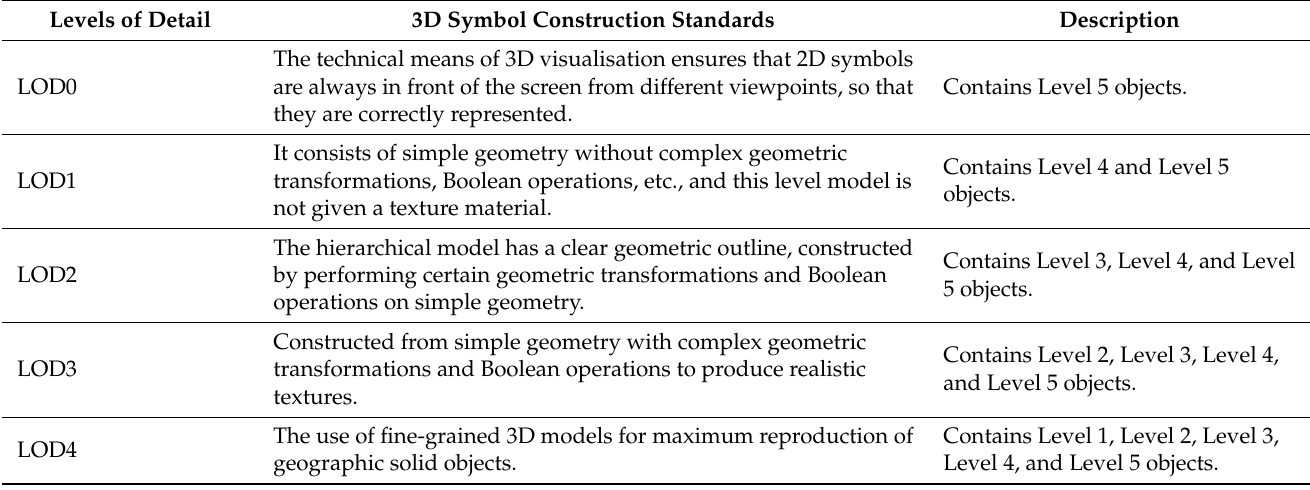
Table 1. Three-dimensional railway scene detail hierarchy